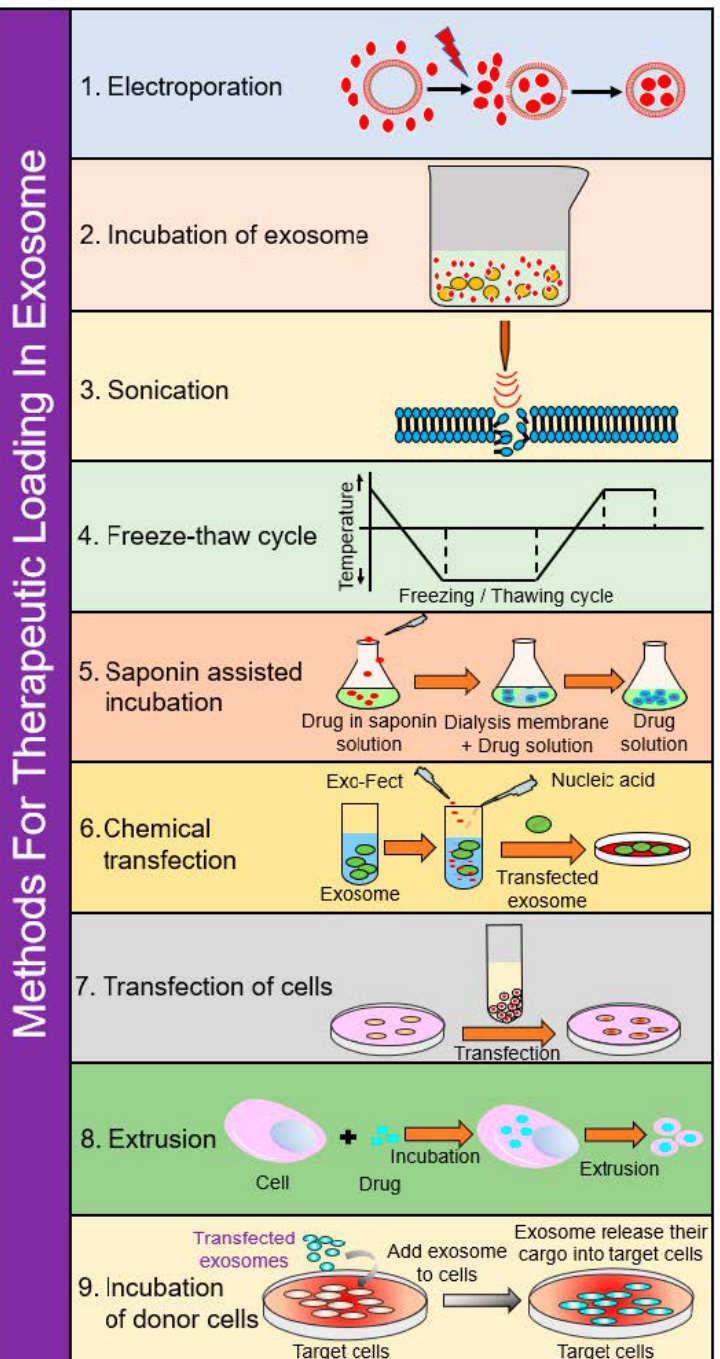
Figure 3. Schematic diagram depicting loading of various cargos in